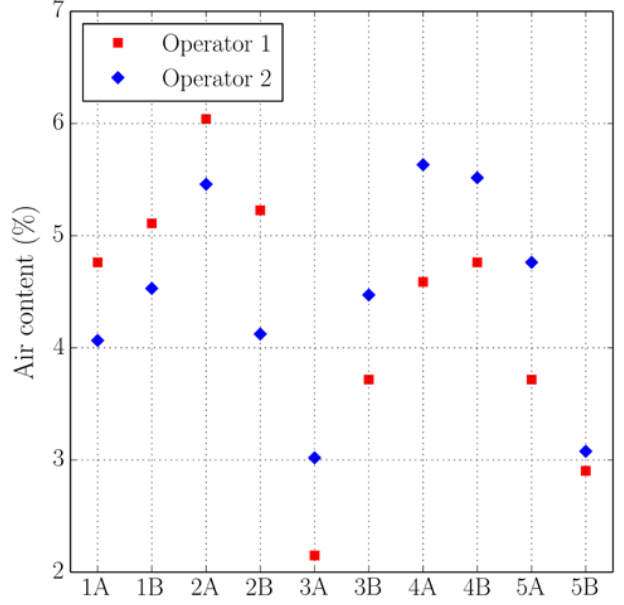
Figure 5. Results of the air content (%) of the slabs studied by two distinct operators.